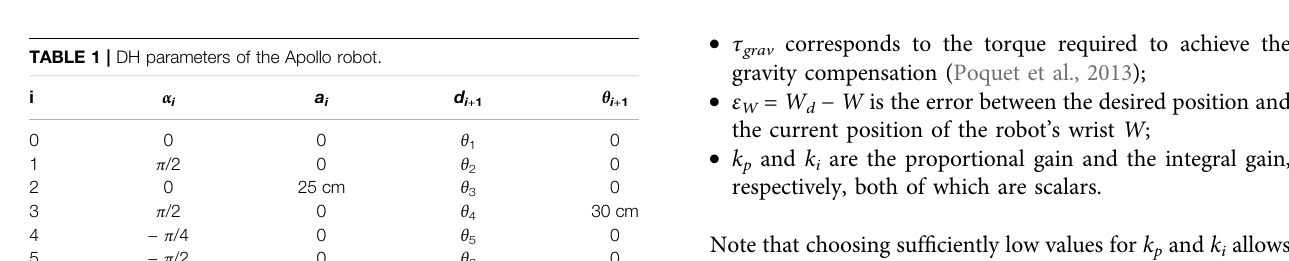
Apollo thus offers 2 different control